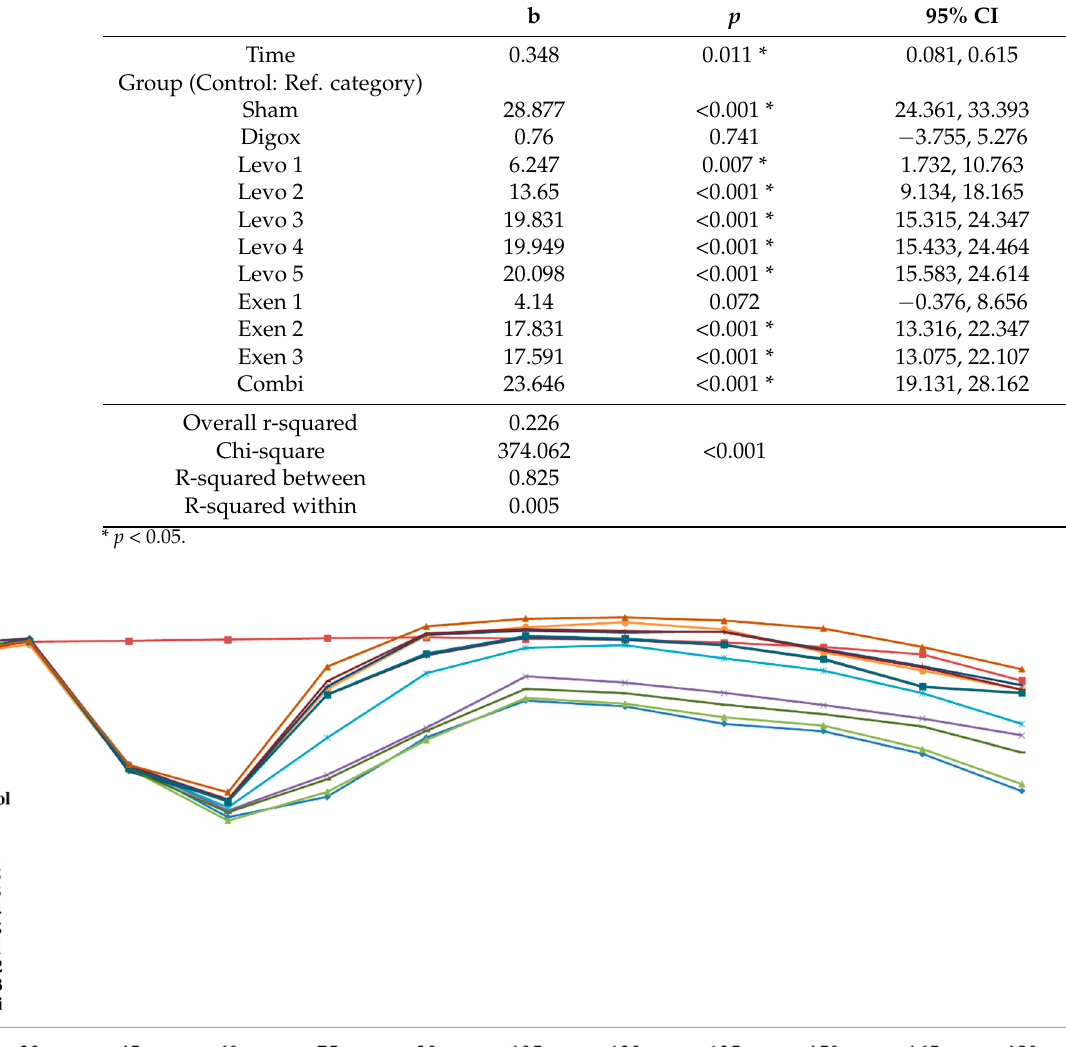
Table 3. Longitudinal analysis for LVDP for all groups.